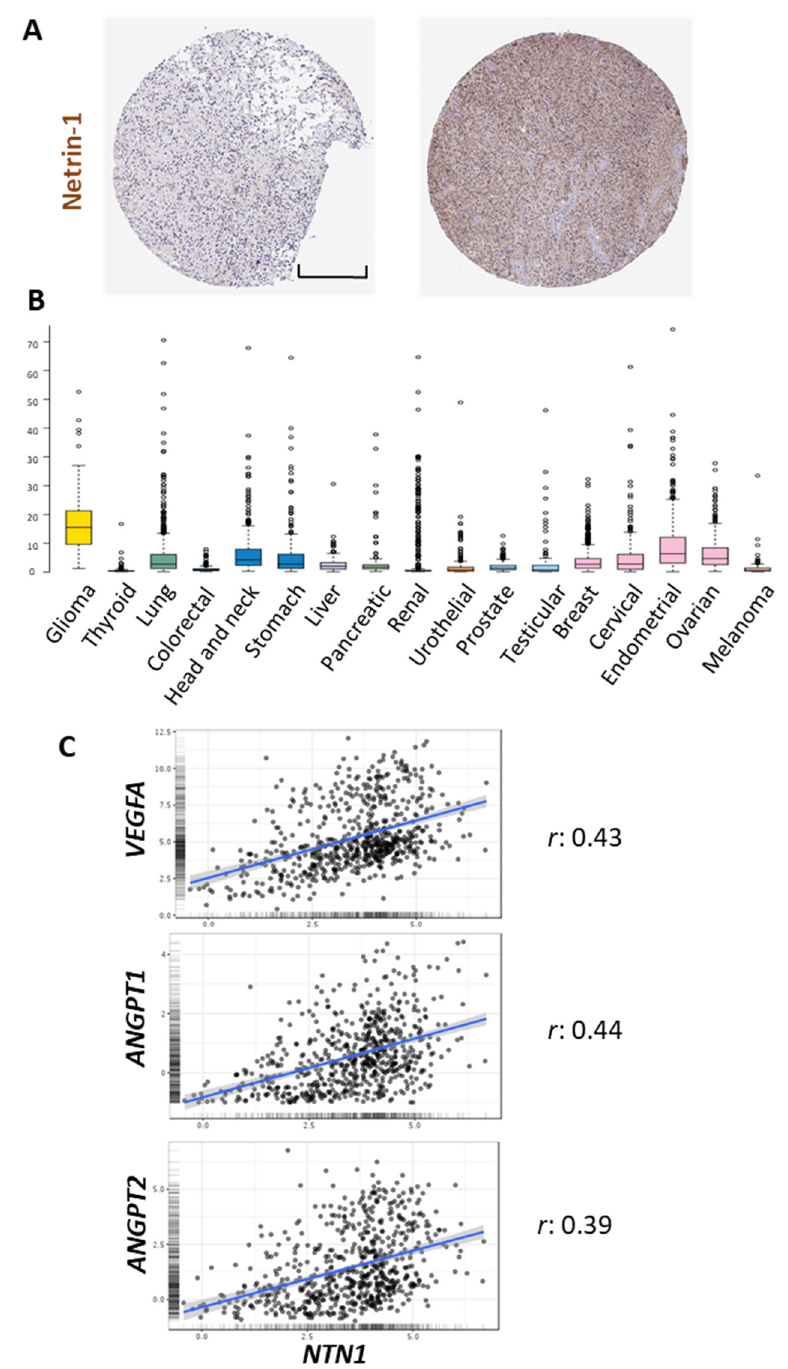
Figure 1. In silico analysis of NTN1 expression in gliomas. ( A ) Representative images of immunohistochemical staining of high-grade glioma samples using a Netrin-1 specific antibody. ( B ) RNA-seq data in 17 cancer types are reported as median FPKM (number Fragments Per Kilobase of exon per Million reads), generated by The Cancer Genome Atlas (TCGA). Data adapted under creative commons license from The Human Protein Atlas [66,67]. Images available from https://www.proteinatlas.org/ENSG00000065320-NTN1/pathology, accessed on 12 May 2021. ( C ) Pearson’s correlation analysis between the expression of NTN1 and VEGFA , ANGPT1 , ANGPT2 , using data from the Chinese Glioma Genome Atlas (CGGA) cohort visualized in the GlioVis data portal [68] (http://gliovis.bioinfo.cnio.es, accessed on 12 May 2021). The correlation coefficient ( r ) is shown on the right. Scale bar in A: 200 μ m.